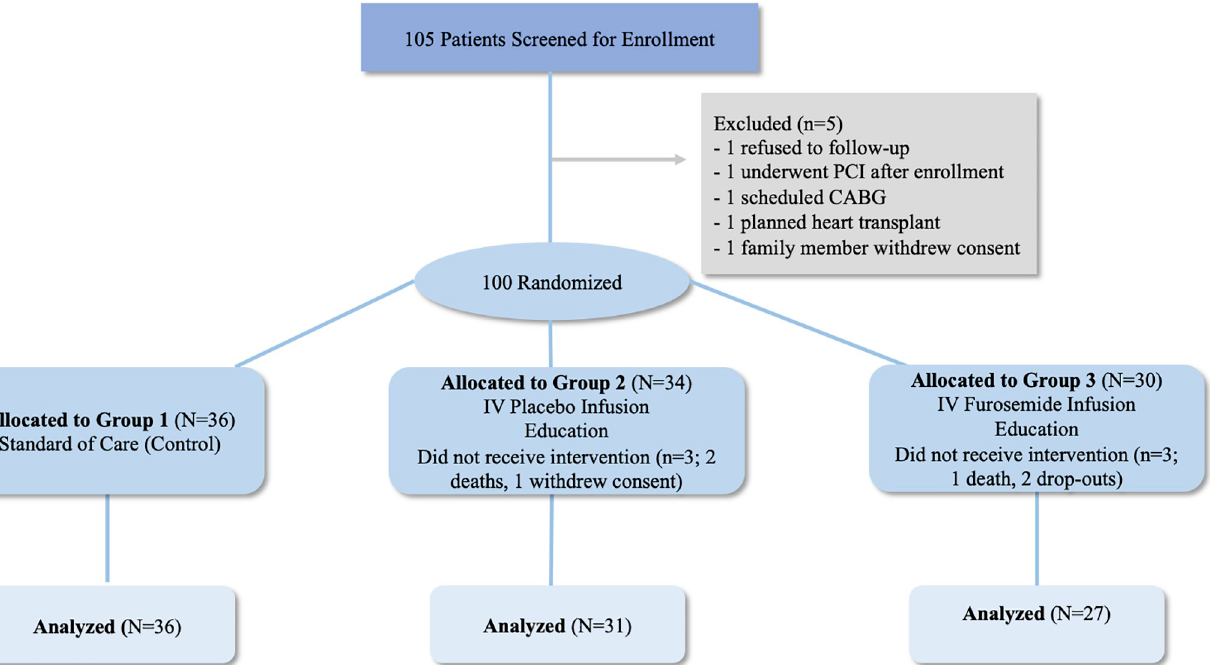
PLOS ONE | https://doi.org/10.1371/journal.pone.0253014 June 25,